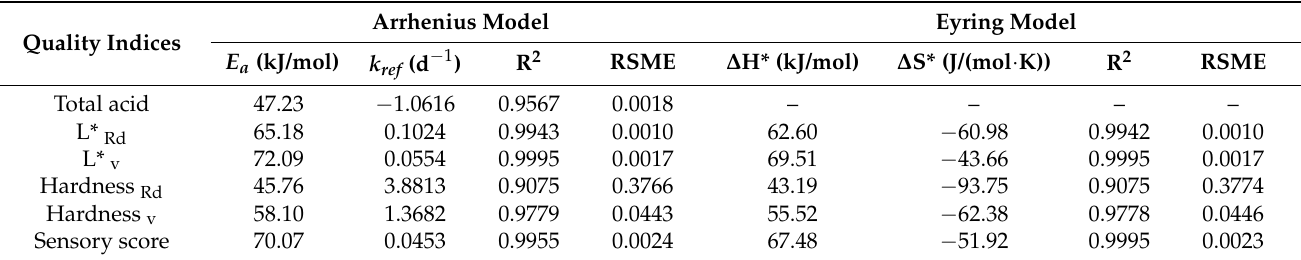
Table 6. Kinetic parameters of quality indices during storage obtained by the Arrhenius and Eyring